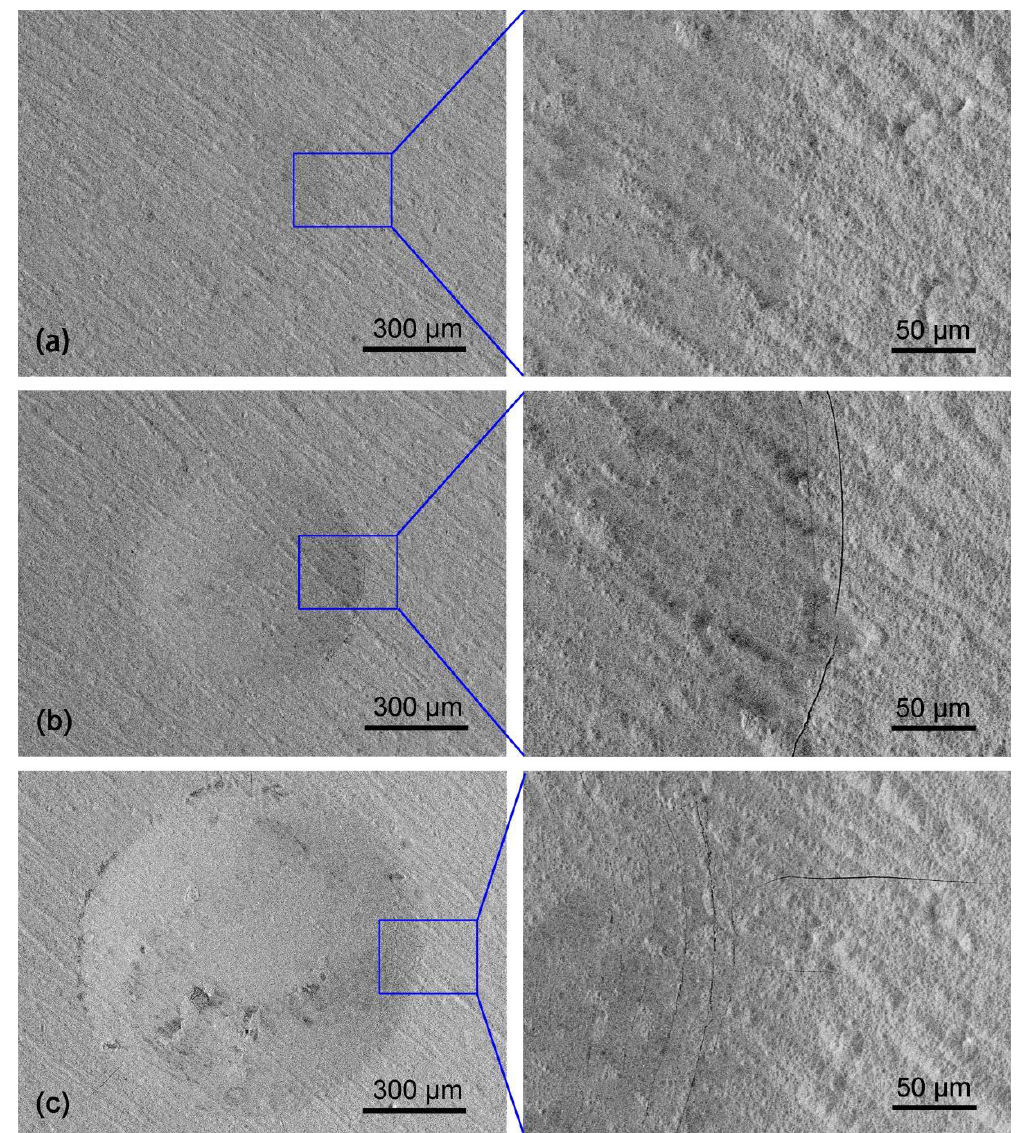
Figure 9. SEM images of Mo surface-modified TC4 after 10,000 impact cycles at ( a ) 100 N, ( b ) 300 N and ( c ) 500 N.